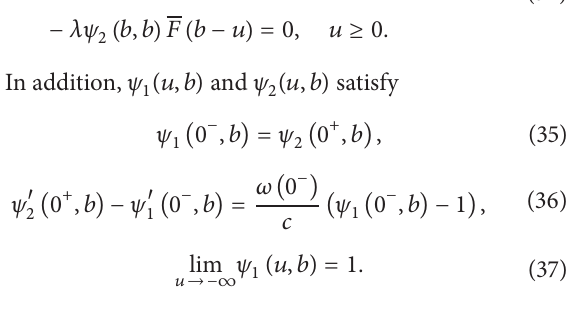
Table 2: Influence of 𝑢 and 𝑏 on 𝑉(𝑢, 𝑏) for 𝛿 = 0.1 , 𝑐 = 2 , 𝜆 = 3 , 𝛼 = 1 , and 𝜔 = 1